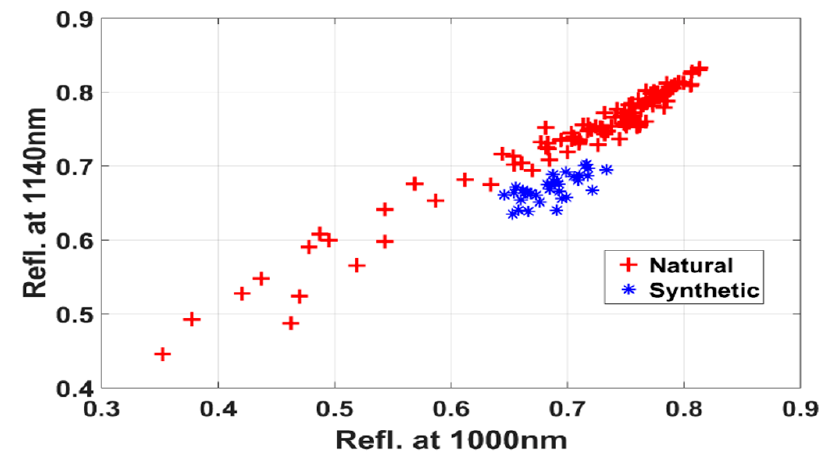
Figure 4. Scatterings of the samples (cases- 4,7,9) in the reflectance space of 1000 nm and 1140 nm to give a visual support of obtained 100% classification accuracy.